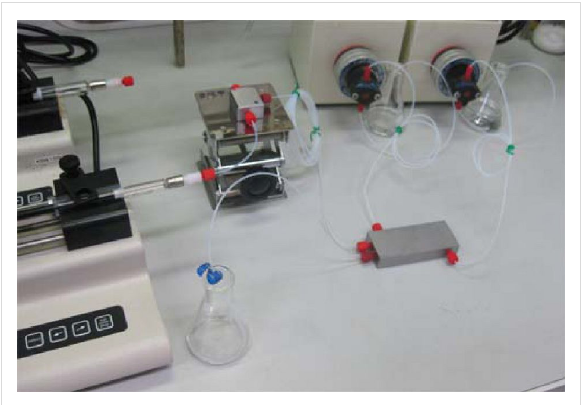
Figure 3: Acid-tolerant microflow system used for the Koch–Haaf